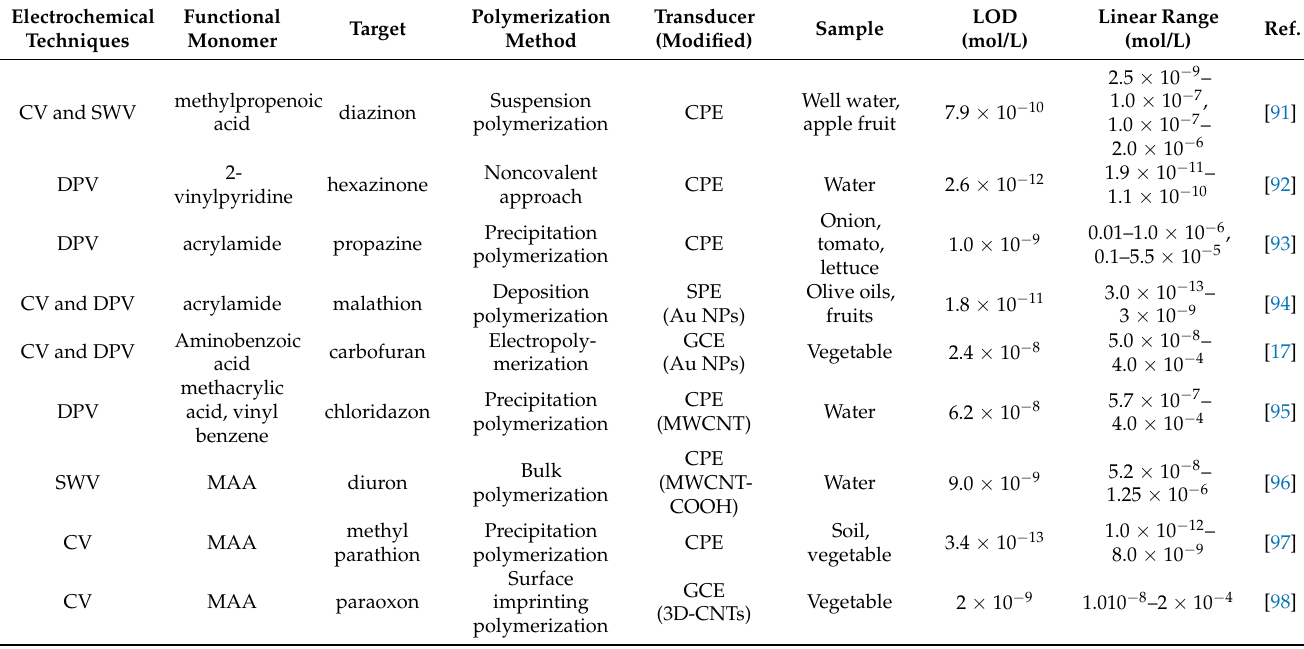
Table 3. Detection of food pesticide residues by different MIP electrochemical biomimetic sensors. Electrochemical